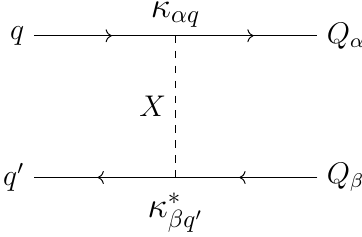
Figure 4. Parton level diagram for B